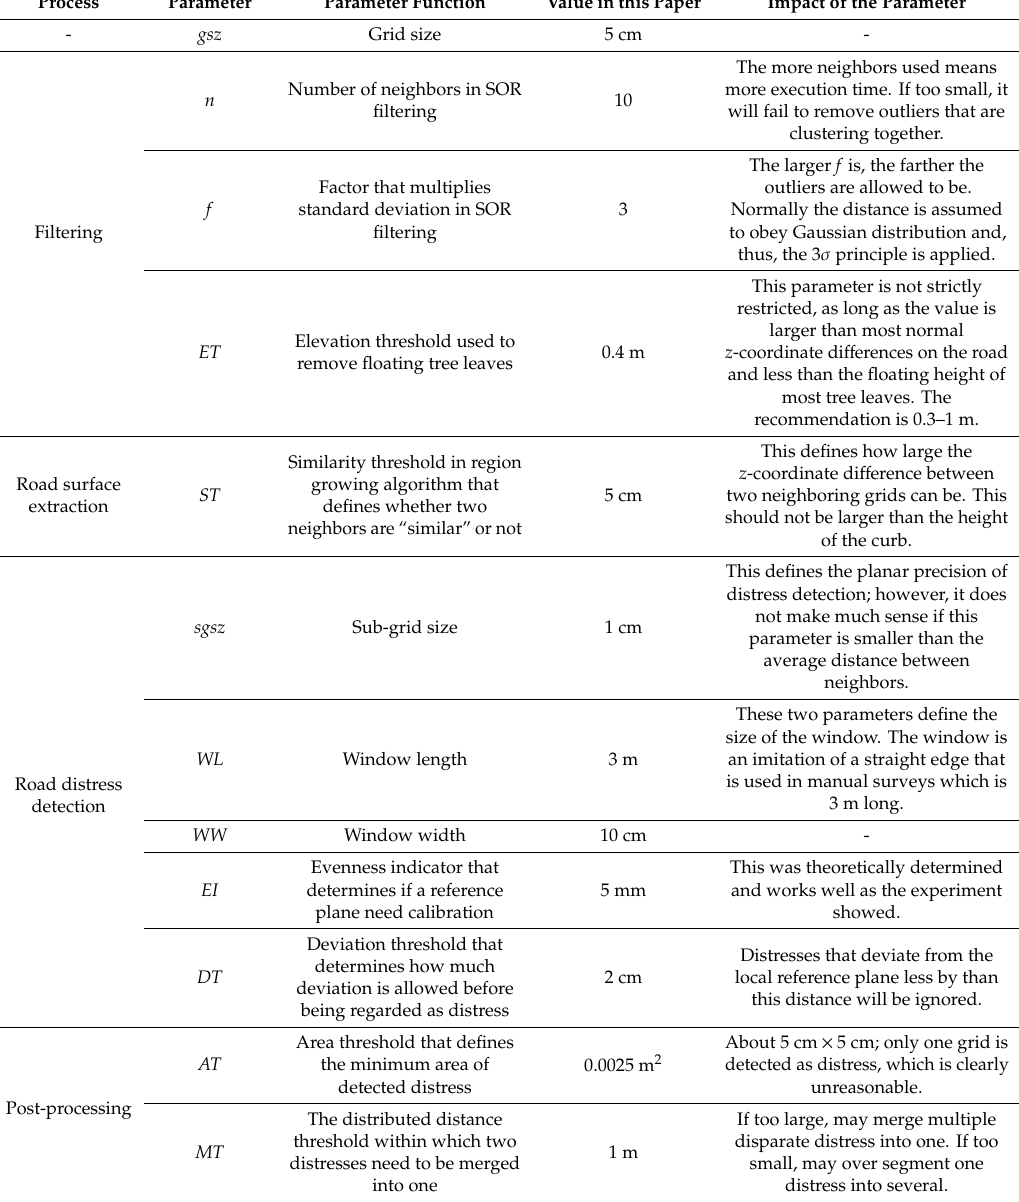
Table 11. Algorithm parameter setting. SOR—statistical outlier